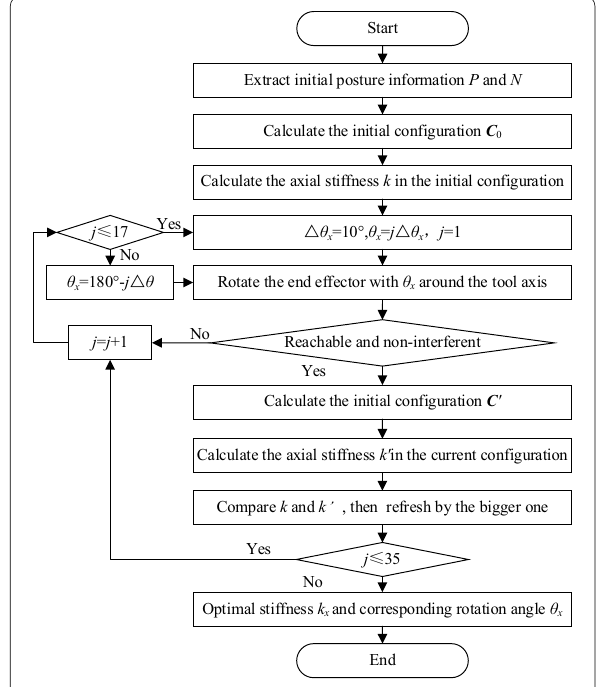
Figure 6 Workflow of configuration optimization